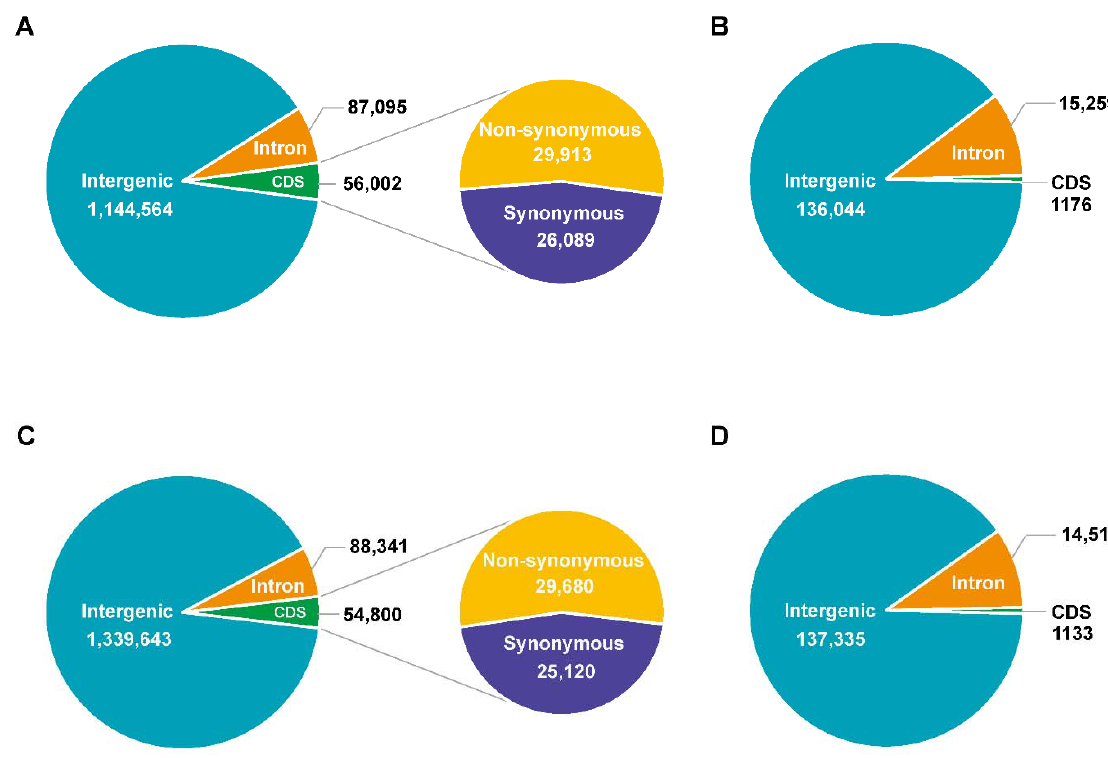
Figure 3. Annotation information of SNPs and InDels. The distributions of SNPs ( A ) and InDels ( B ) in the intergenic and genic regions of 9053. The distributions of SNPs ( C ) and InDels ( D ) in the intergenic and genic regions of sGK9708.